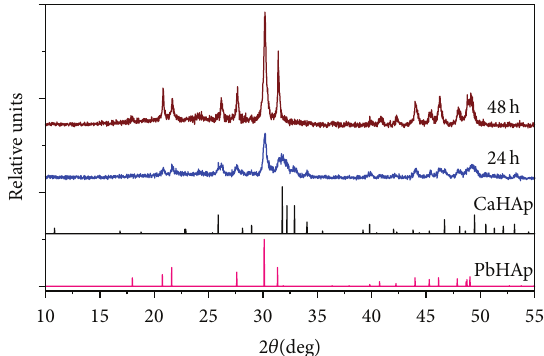
Figure 5: XRD patterns of products after refluxing in lead nitrate solution (917mg/L) for 24 h and 48